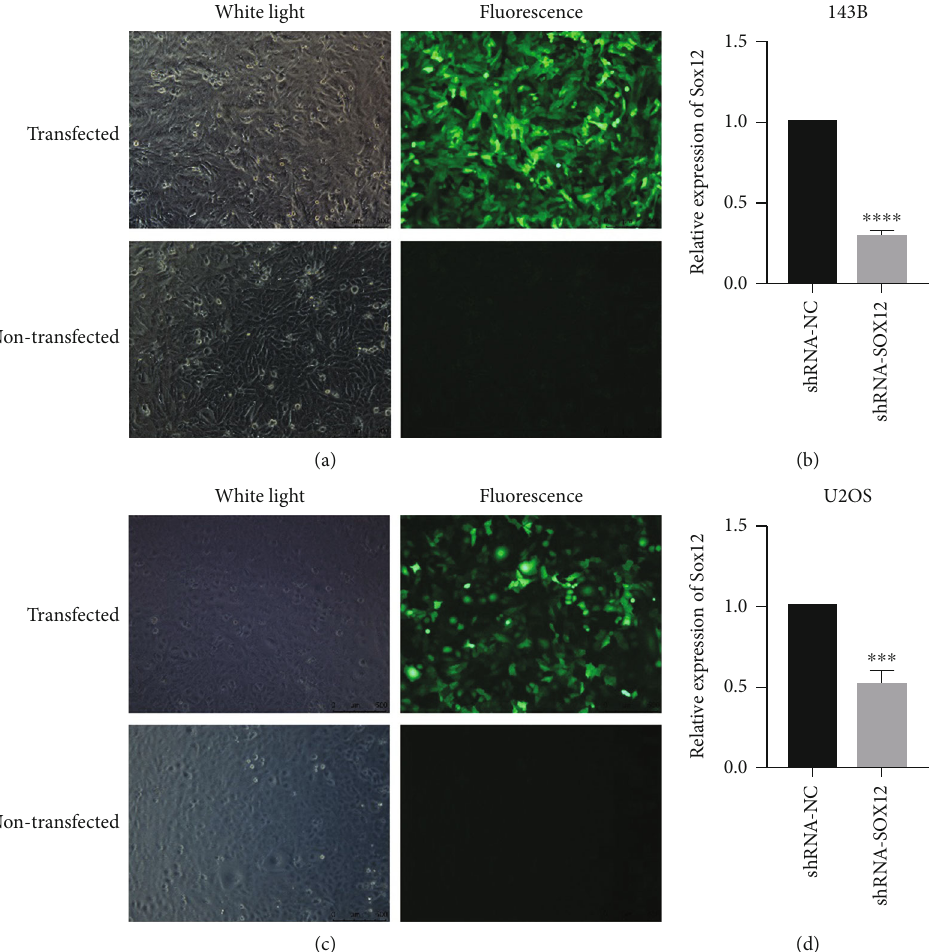
Figure 3: SOX12 expression decreases in cells transfected with lentivirus. (a) Transfected and untransfected 143B cells under white light and fl uorescence. (b) SOX12 expression in 143B cells transfected with shRNA-NC and shRNA-SOX12. (c) Transfected and untransfected U2OS cells under white light and fl uorescence. (d) SOX12 expression in U2OS cells transfected with shRNA-NC and shRNA-SOX12. ∗∗∗ p < 0 : 001 , ∗∗∗∗ p < 0 : 0001